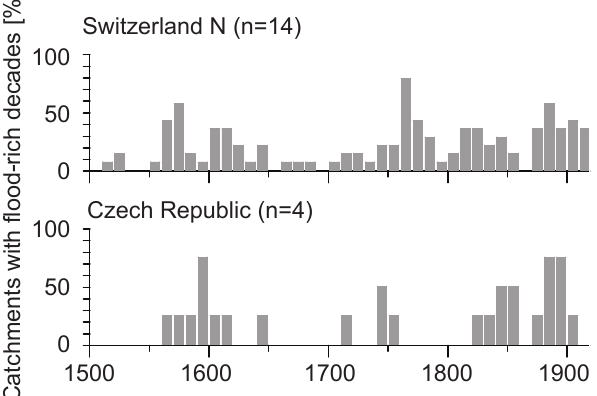
Fig. 8. Comparison of flood frequencies between Switzerland and the Czech Republic (data from Br´azdil et al., 2006b), for the period